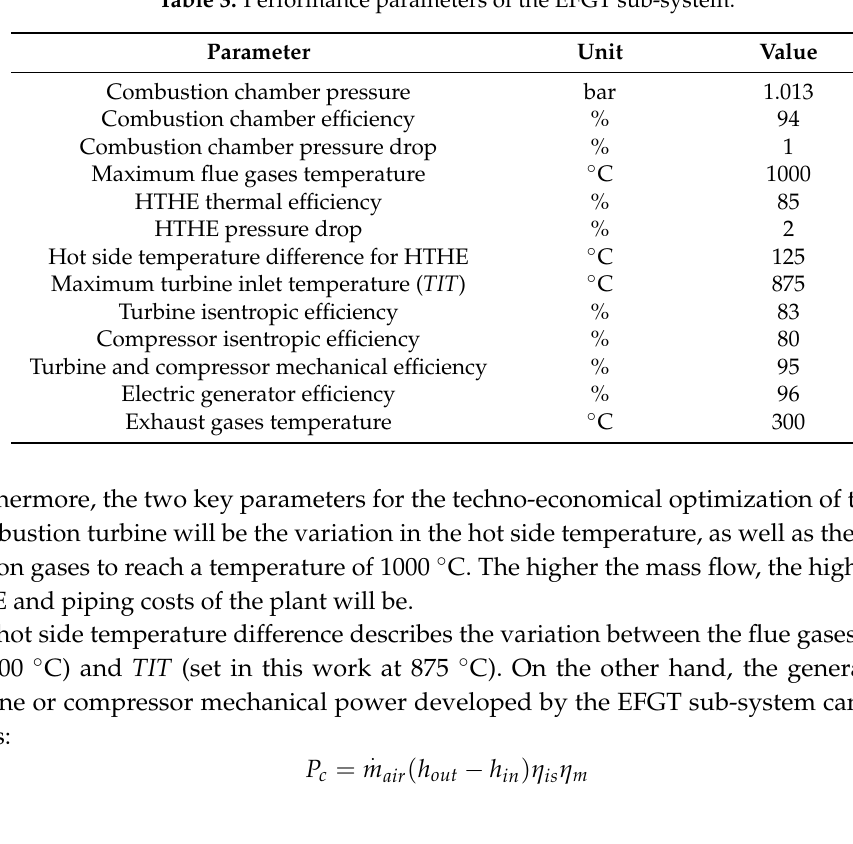
Table 3. Performance parameters of the EFGT